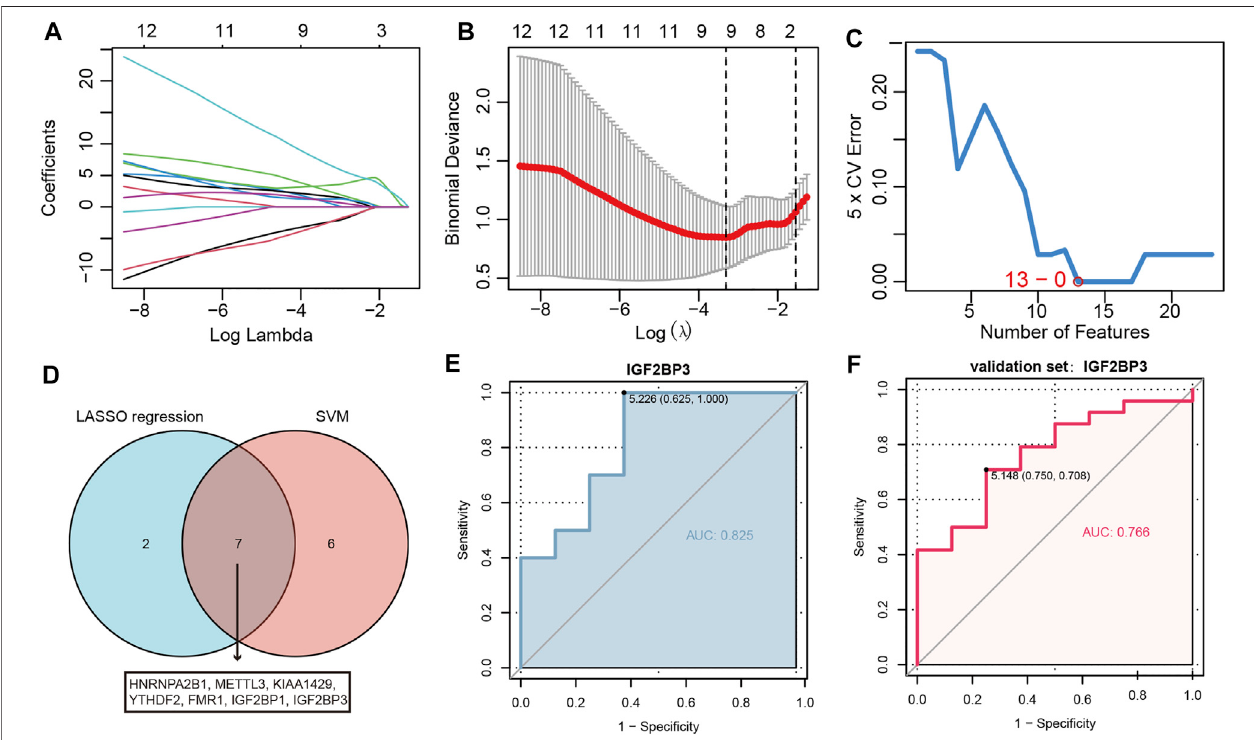
FIGURE 3 | IGF2BP3 can well distinguish severe OSA from normal individuals. (A) LASSO coef fi cient pro fi les of m6A regulators. (B) 10-fold cross-validation for tuningparameter selectioninthe LASSOregression. (C) Thepoint highlightedindicates thelowest errorrate, and thecorrespondingm6Aregulators atthis point arethe bestsignatureselectedbySVM. (D) VenndiagramdemonstratingsevenOSA-relatedgenessharedbytheLASSOandSVMalgorithms. (E,F) Thediscriminationabilityof IGF2BP3 was evaluated by ROC curve and AUC value based on training set GSE135917 (E) and validation set GSE38792 (F) . AUC: area under the curve.